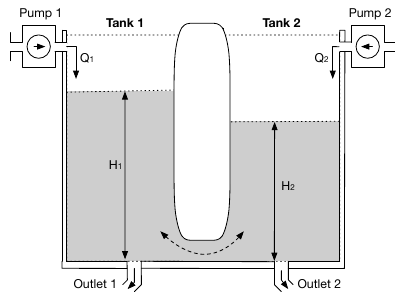
Figure 2. Diagram of the coupled tanks system. Adapted from [27].